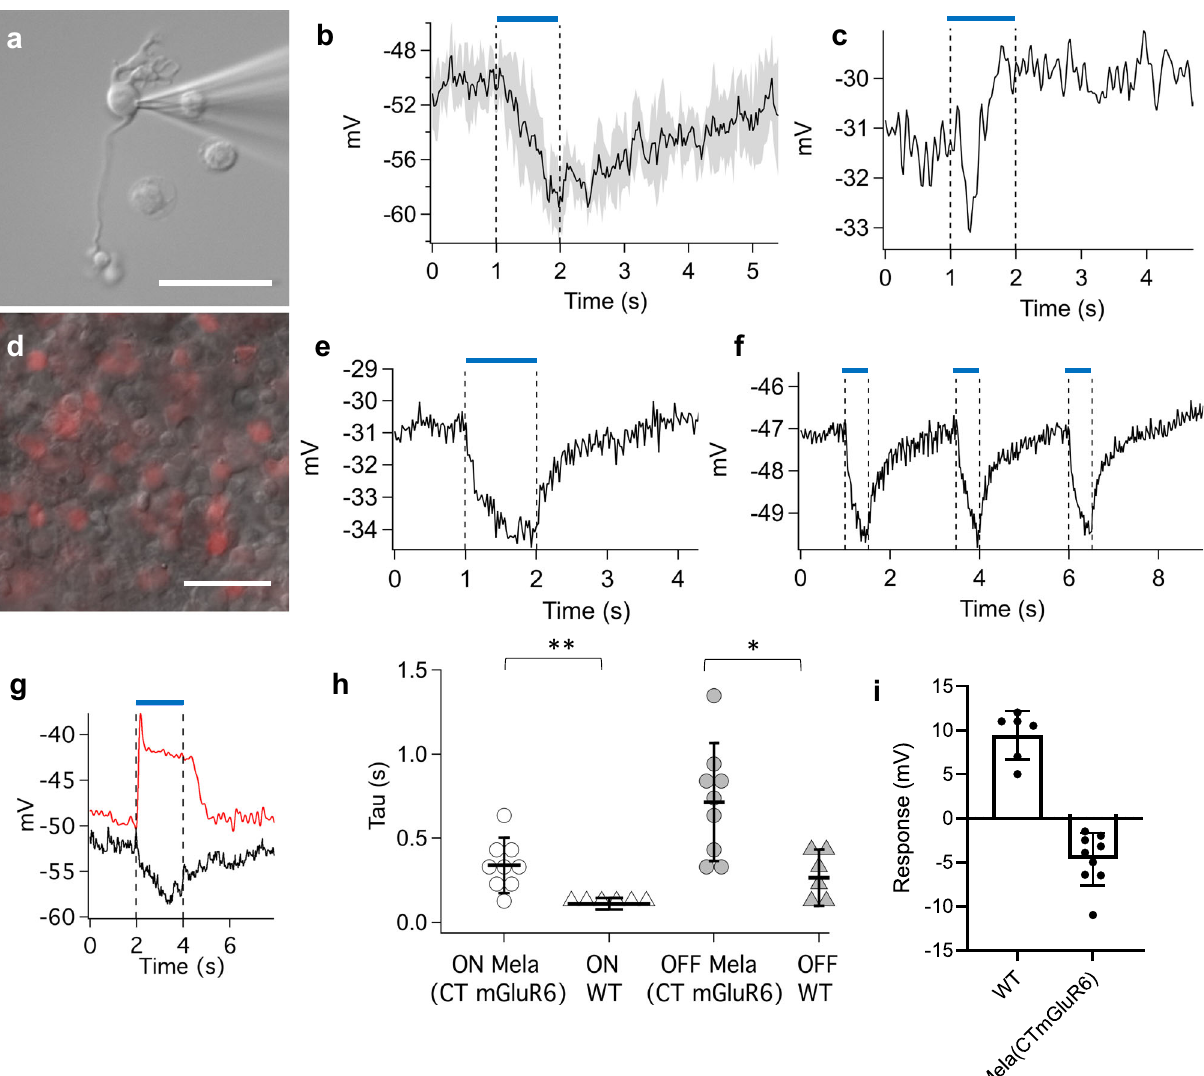
Fig. 3 Mela(CTmGluR6) driven light responses in OBCs. a We targeted isolated OBCs for electrophysiological recordings by their characteristic morphology under IR-DIC optics and reporter gene expression. b Isolated rod bipolar cells responded with a small but consistent hyperpolarization to light (470 nm; 10 14 photons/cm 2 /s; trace shows average response of 6 cells with shaded area indicating 1 SD). c An isolated cone OBC with a fast, biphasic response to the same light stimulus presented in B possibly suggests diverse intrinsic processing within different OBC types. d In whole mount rd1 retinas, OBCs were targeted for recording by reporter gene expression and by the characteristic size and location of their cell bodies. Recordings from transfected rod bipolar cells in the whole mount rd1 retina had robust light responses with a faster recovery time compared to isolated cells ( e ; 470 nm; 10 13 photons/ cm 2 /s) and could be repeatedly triggered at 0.4 Hz ( f ). g Light responses from a transduced rod bipolar cell in a rd1 whole mount retina (black) compared to a light response form a rod bipolar cells in a wild type C57BL/6 slice preparation of the retina (red; 470 nm; 1 × 10 13 and 1 × 10 11 photons/cm 2 /s, respectively). h Tau ON and Tau OFF values of wild type OBCs ( n = 6) and Mela(CTmGluR6)-transduced rd1 OBCs ( n = 9). Although time constants recorded from wildtype cells were on average faster, both, the ON and OFF time constants of some treated cells overlapped with those recorded from wildtype cells ( p = 0.0055 and 0.0125, respectively). i Average response amplitudes of the same responses presented in ( g ) [ n (WT) = 6, n(Mela(CTmGluR6) = 9]. Scale bars in a and d 50 µ m. Data in panels h , i depicted as means ± SD, dark points represent individual